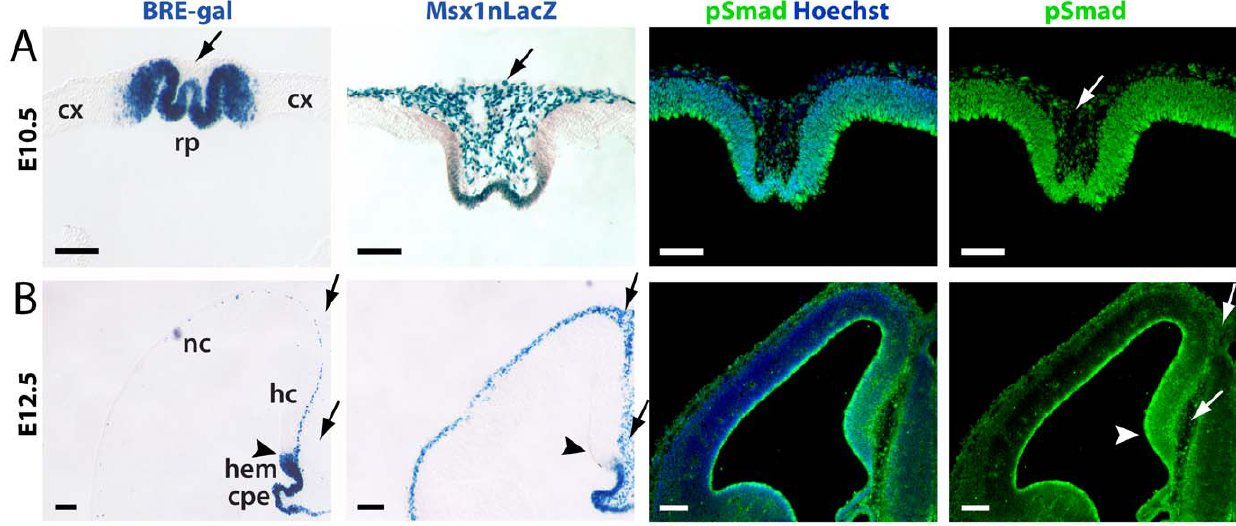
Figure 2. BRE-gal coexpression with other Bmp signaling readouts in the DTM. Xgal or IHC of E10.5 (A) and E12.5 (B) coronal sections. BRE- gal is sharply restricted to the DTM, and excluded from cortex and mesenchyme. pSmad is present in the neuroepithelium (graded from high dorsomedial to low ventrolateral) and in the mesenchyme at both stages. Like pSmad, but in contrast to BRE-gal, Msx1-nlacZ is expressed in both the neuroepithelium and mesenchyme. Within the neuroepithelium, the Msx1-nlacZ expression domain is smaller than the BRE-gal domain at both stages. Scale bars: 100 um. Arrows designate mesenchyme; arrowheads designate the cortex-hem boundary. Abbr: cpe, choroid plexus epithelium; cx, cortex; hc, hippocampal primordium; nc, neocortical primordium; rp, roof plate.